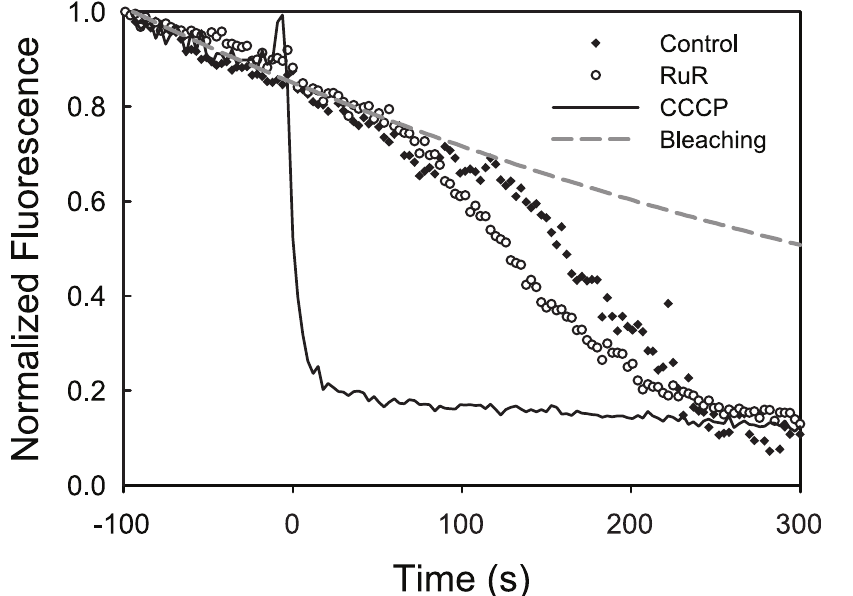
Figure 3. Normalized traces of air bubble contact-induced loss of mitochondrial membrane potential, compared to treatment with CCCP, a mitochondrial uncoupler. Normalized representative traces of fluorescence signal (from Figure 2) obtained from HUVEC loaded with DY m indicator TMRM responding to air bubble contact under control conditions (solid diamonds) or following pre-treatment with 1 m mol/L ruthenium red (open circles). Solid line represents response to treatment with 2 m mol/L CCCP. Dashed grey line represents the expected exponential decay of the signal, primarily due to photobleaching.